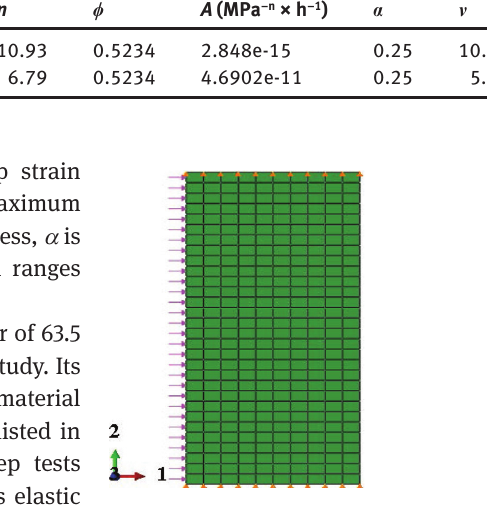
Table 2: Material constants for Cr25Ni35Nb alloy at 1050 °C and 950 °C